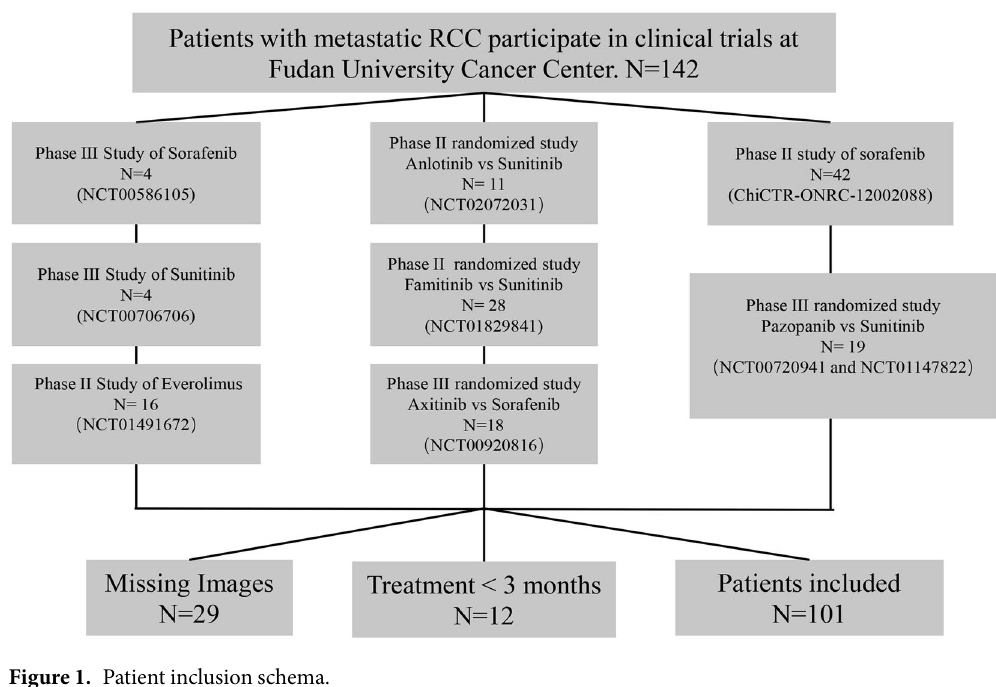
Figure 1. Patient inclusion